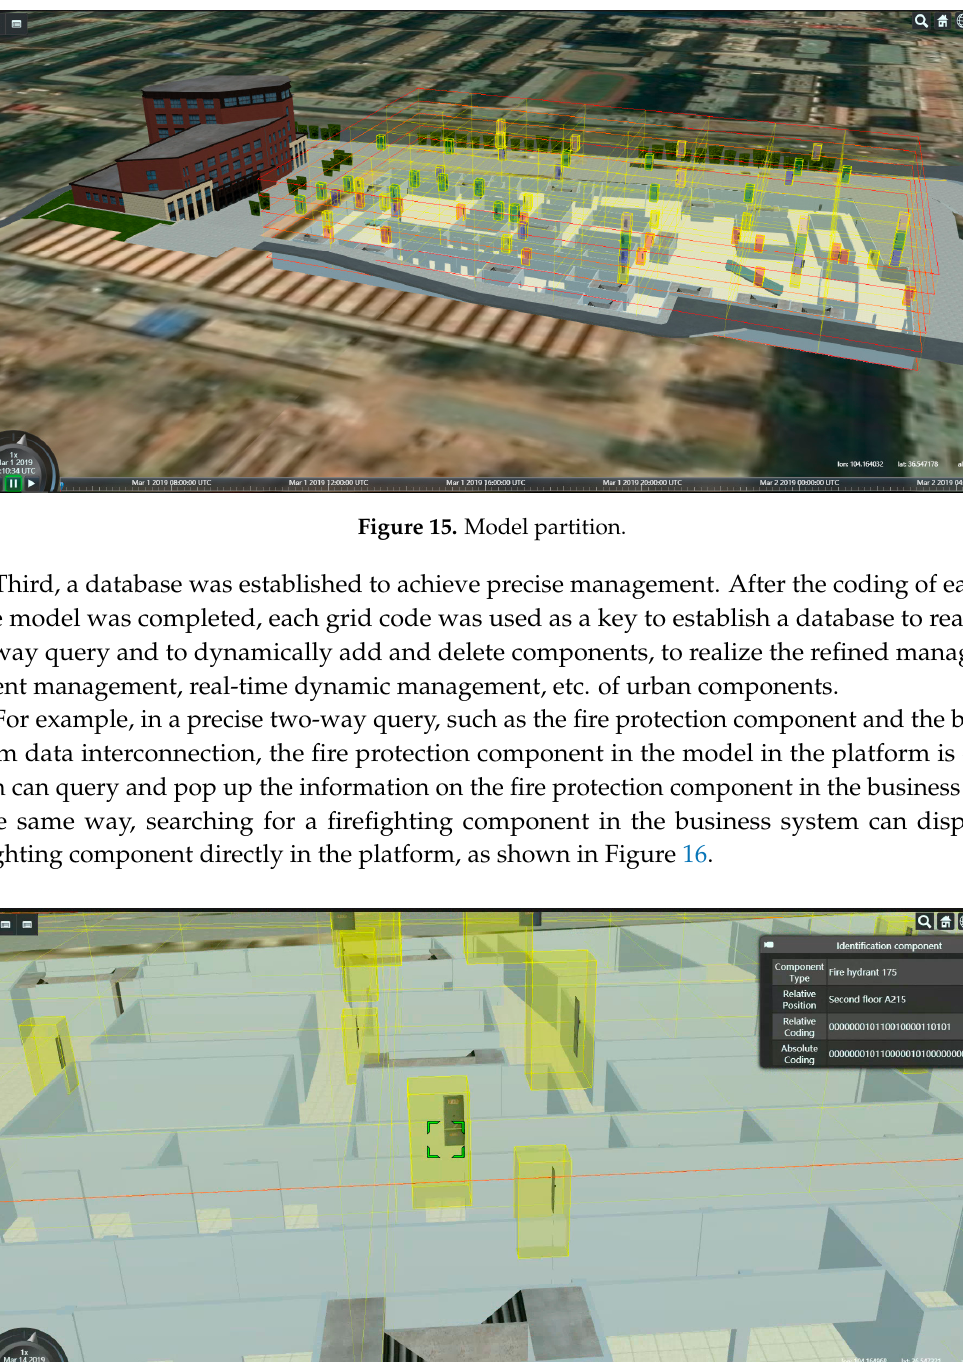
Figure 16. Fire component inquiry business system data display.